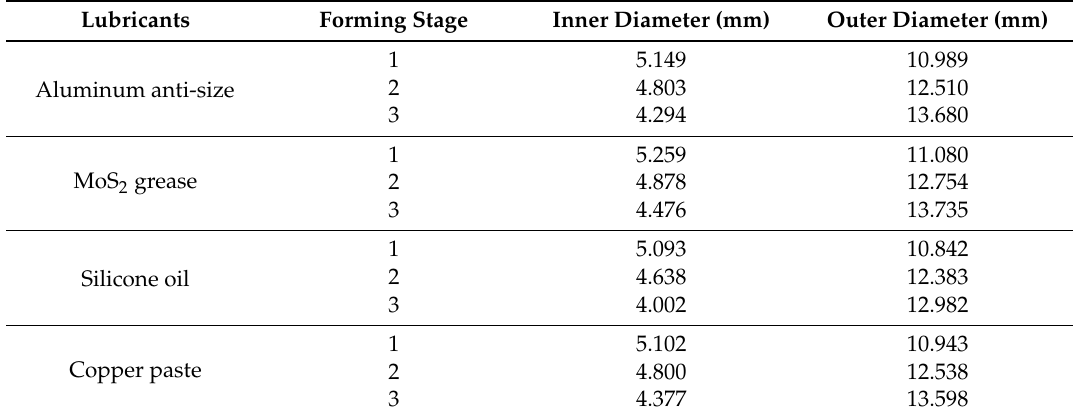
Table 2. Dimensional measurements after conducting the RCTs.